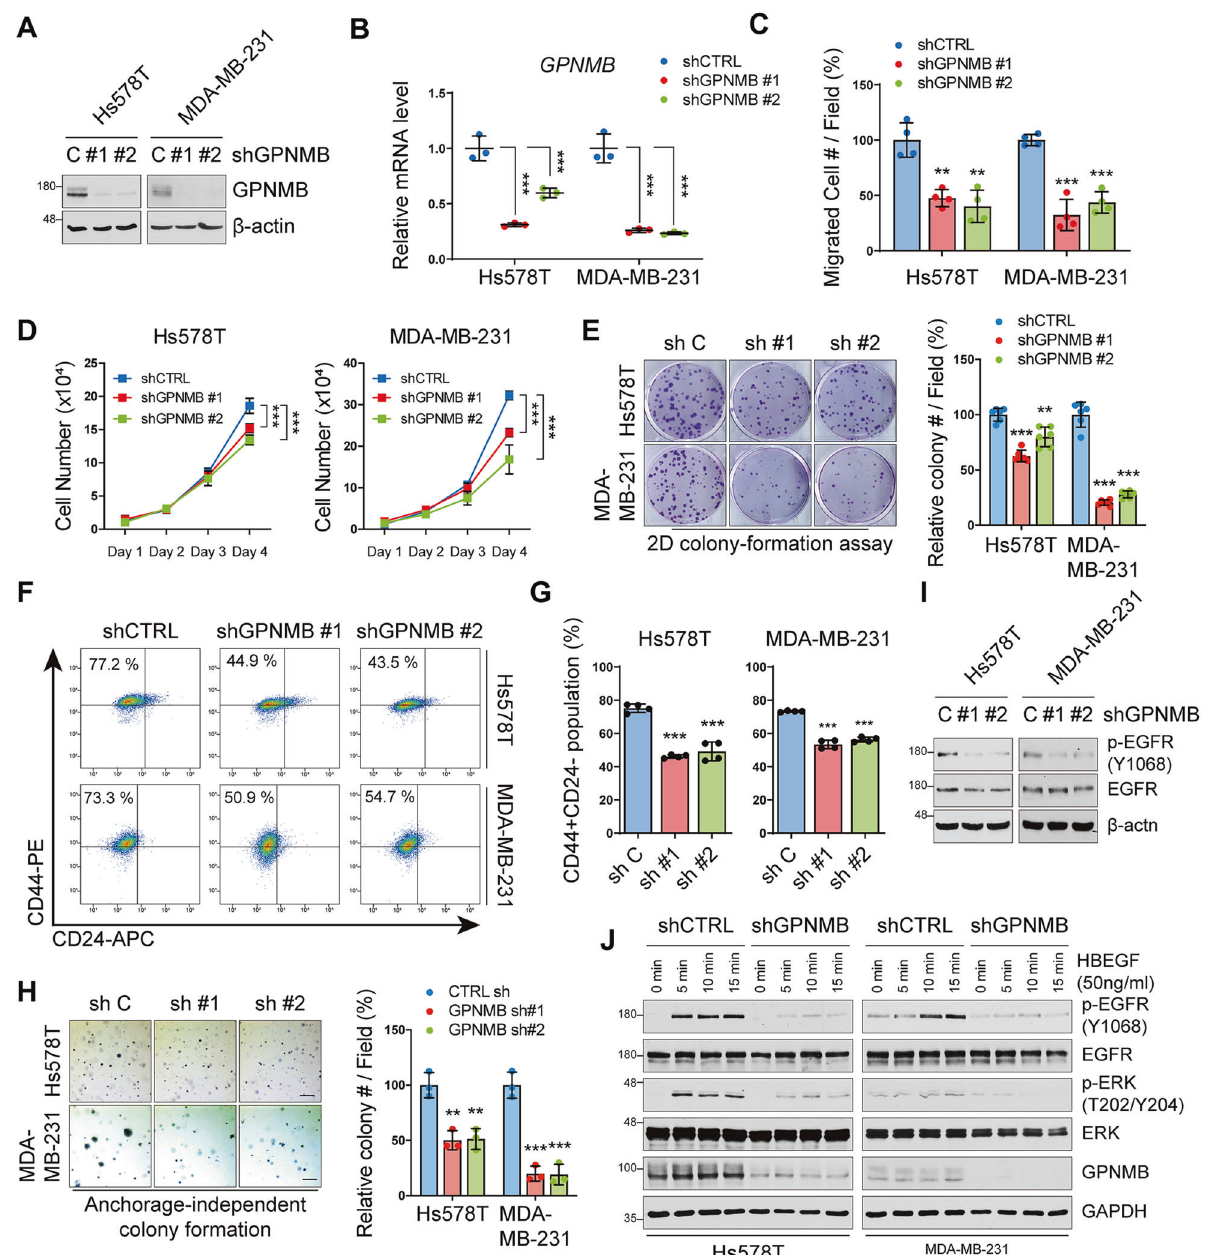
Fig. 7 Knockdown of GPNMB drives anti-tumorigenic effect in vitro. A Western blot analysis of whole cell lysate of Hs578T and MDA-MB-231 GPNMB knockdown cell lines with indicated antibody. β -actin was used as a loading control. B RT-qPCR analysis showed GPNMB mRNA level in Hs578T and MDA-MB-231 GPNMB knockdown cell lines. Each value was normalized with GAPDH. Mean ± SD ( n = 3). P values were calculated with one-way ANOVA with a post-hoc Dunnett ’ s multiple comparison test (*** p < 0.0005). C Transwell migration assays were assessed with Hs578T and MDA-MB-231 GPNMB knockdown cell lines. Each value was normalized with the value of shCTRL. Mean ± SD ( n = 4). P -values were calculated with one-way ANOVA with a post-hoc Dunnett ’ s multiple comparison test (*** p < 0.0005). D Cell proliferation assays were performed with Hs578T and MDA-MB-231 GPNMB knockdown cell lines. Mean ± SD ( n = 3). P -values were calculated with two-way ANOVA with a Bonferroni posttest (*** p < 0.0005). E 2D colony formation assays were performed with Hs578T and MDA-MB-231 GPNMB knockdown cell lines. Each value was normalized with the value of CTRL cell line. Mean ± SD ( n = 6). P -values were calculated with one-way ANOVA with a post-hoc Dunnett ’ s multiple comparison test (*** p < 0.0005). F , G FACS analysis of CD44 + CD24 - cell population in the Hs578T and MDA-MB-231 GPNMB knockdown cell lines. Bar graphs ( G ) indicated the percentage of CD44 + CD24 - cell population in each cell line. Mean ± SD ( n = 4). P -values were calculated with one-way ANOVA with a post-hoc Dunnett ’ s multiple comparison test (*** p < 0.0005). H Anchorage-independent colony formation assays were performed with Hs578T and MDA-MB-231 CCN3 knockdown cell lines (scale bar = 50 μ m). Each value was normalized based on the value of the CTRL cell line. Mean ± SD ( n = 3). P -values were calculated with one-way ANOVA with a post-hoc Dunnett ’ s multiple comparison test (** p < 0.005, *** p < 0.0005). I Western blot analysis of whole cell lysate of GPNMB knockdown cell lines with indicated antibody. β -actin was used as a loading control. J Western blot analysis of whole cell lysate of GPNMB knockdown cell lines with indicated antibody. Each cell line treated with HBEGF (50 ng/ml) at the indicated time points. GAPDH was used as a loading control.